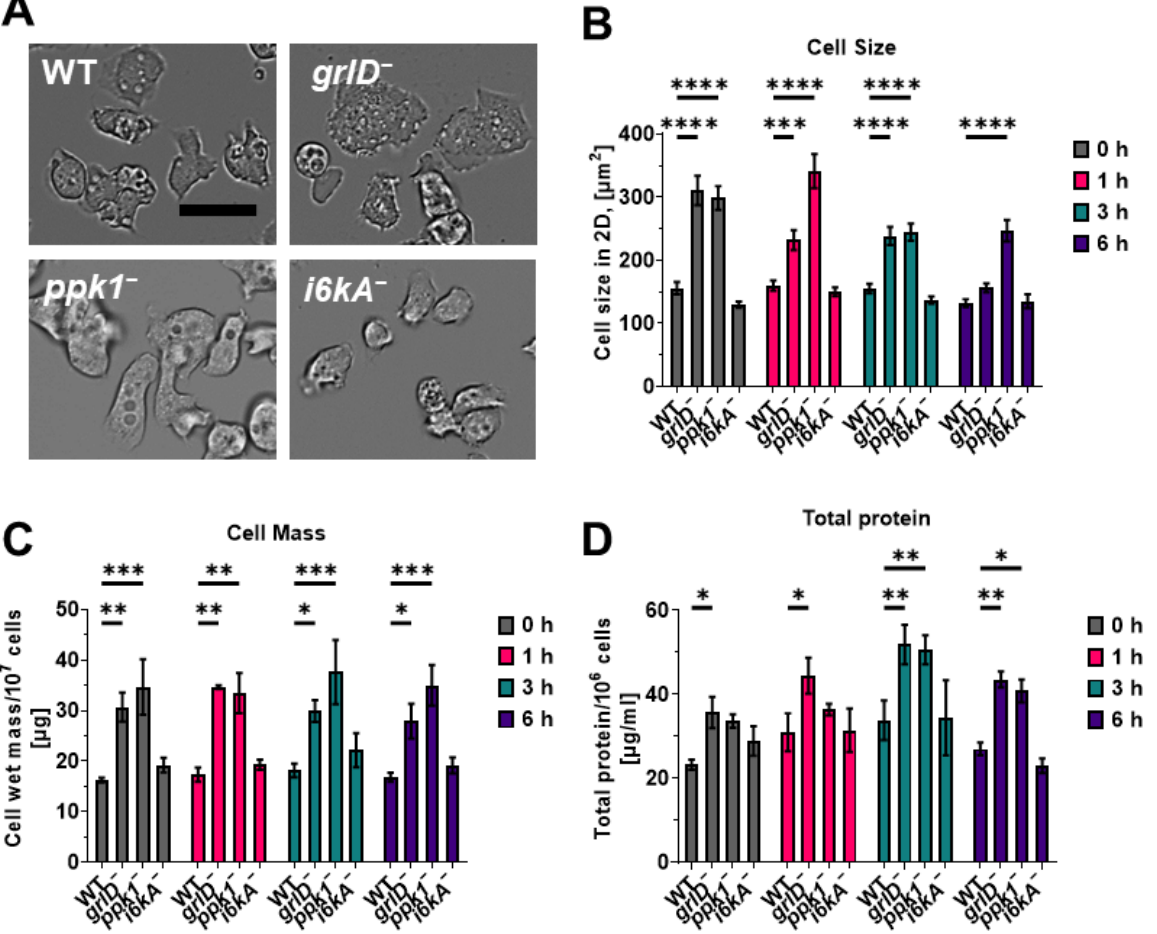
Figure 5. Starvation does not alter cell size, mass, and total protein content. ( A ) Representative images of vegetative WT, grlD − , ppk1 − , and i6kA − cells growing in submerged stationary culture are shown from 3 independent experiments. Bar is 20 µ m. ( B ) Cell areas of 10 6 cells/mL WT, grlD − , ppk1 − , and i6kA − cells starved in PBM in submerged stationary culture for 0, 1, 3, and 6 h. At least 50 cells from three independent experiments were taken to measure the cell size. ( C , D ) Cell mass per 10 7